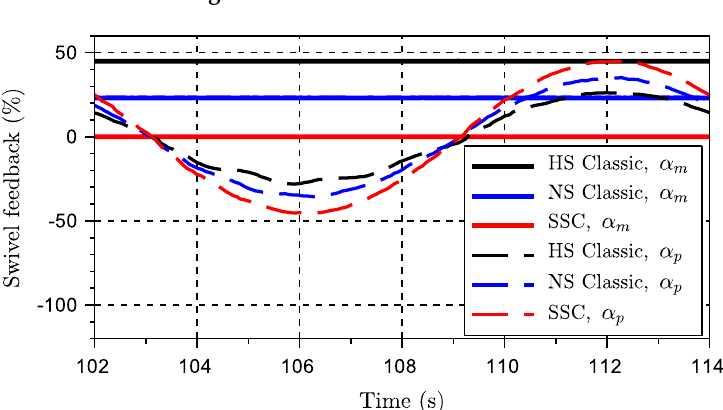
Figure 17. Control error for scenario 1.